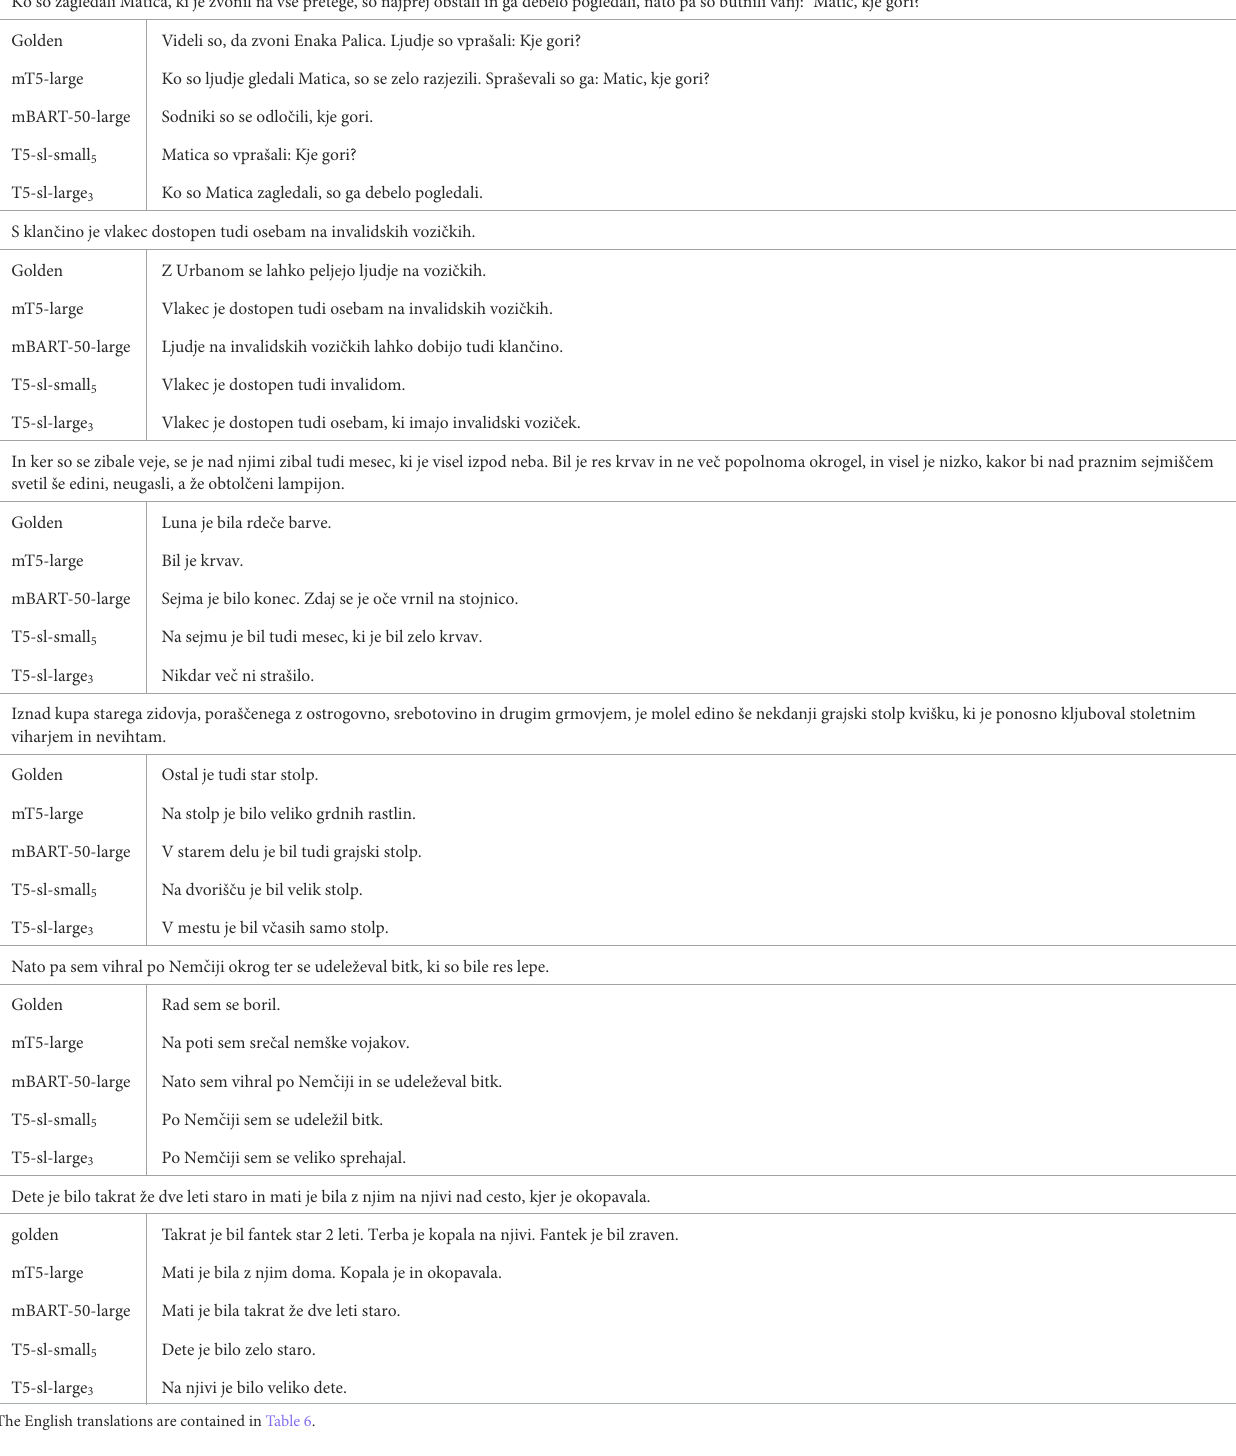
TABLE 7 Original Slovene examples of generated simplified sentences on the text simplification task for the best performing models. Ko so zagledali Matica, ki je zvonil na vse pretege, so najprej obstali in ga debelo pogledali, nato pa so butnili vanj: "Matic, kje